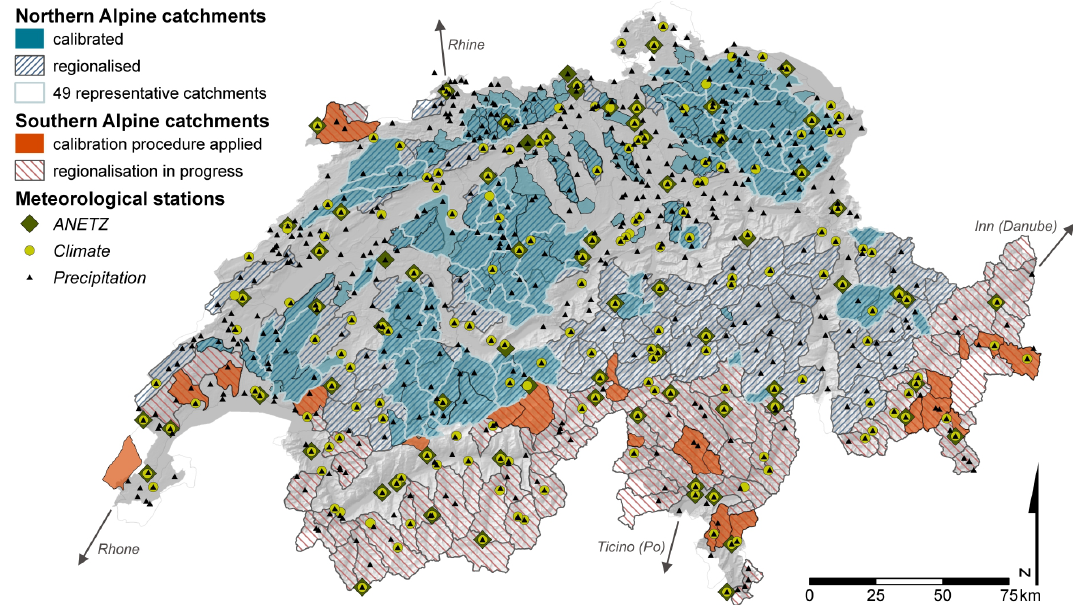
Fig. 1. Mesoscale catchments for calibration and regionalisation and meteorological network of Switzerland. Those catchments where model parameters were calibrated, validated and regionalised beforehand (Viviroli et al., 2009b,c) are indicated by blue colour, the Southern Alpine catchments presented in this study are shown in red. Note that a few catchments in northwest and west Switzerland belong to the Rhone basin draining